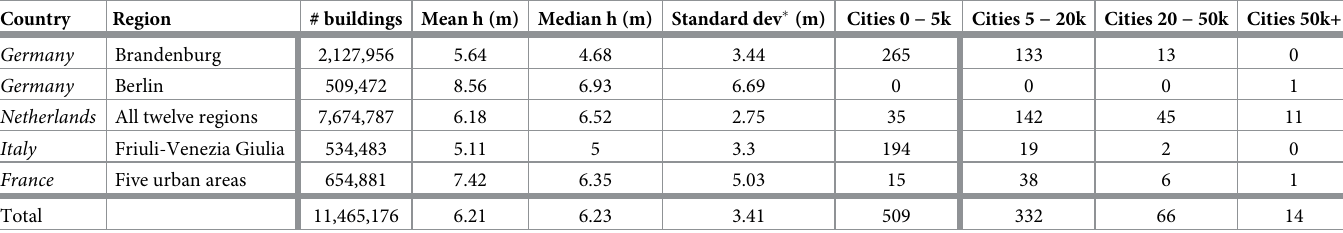
Table 1. Summary statistics of the full